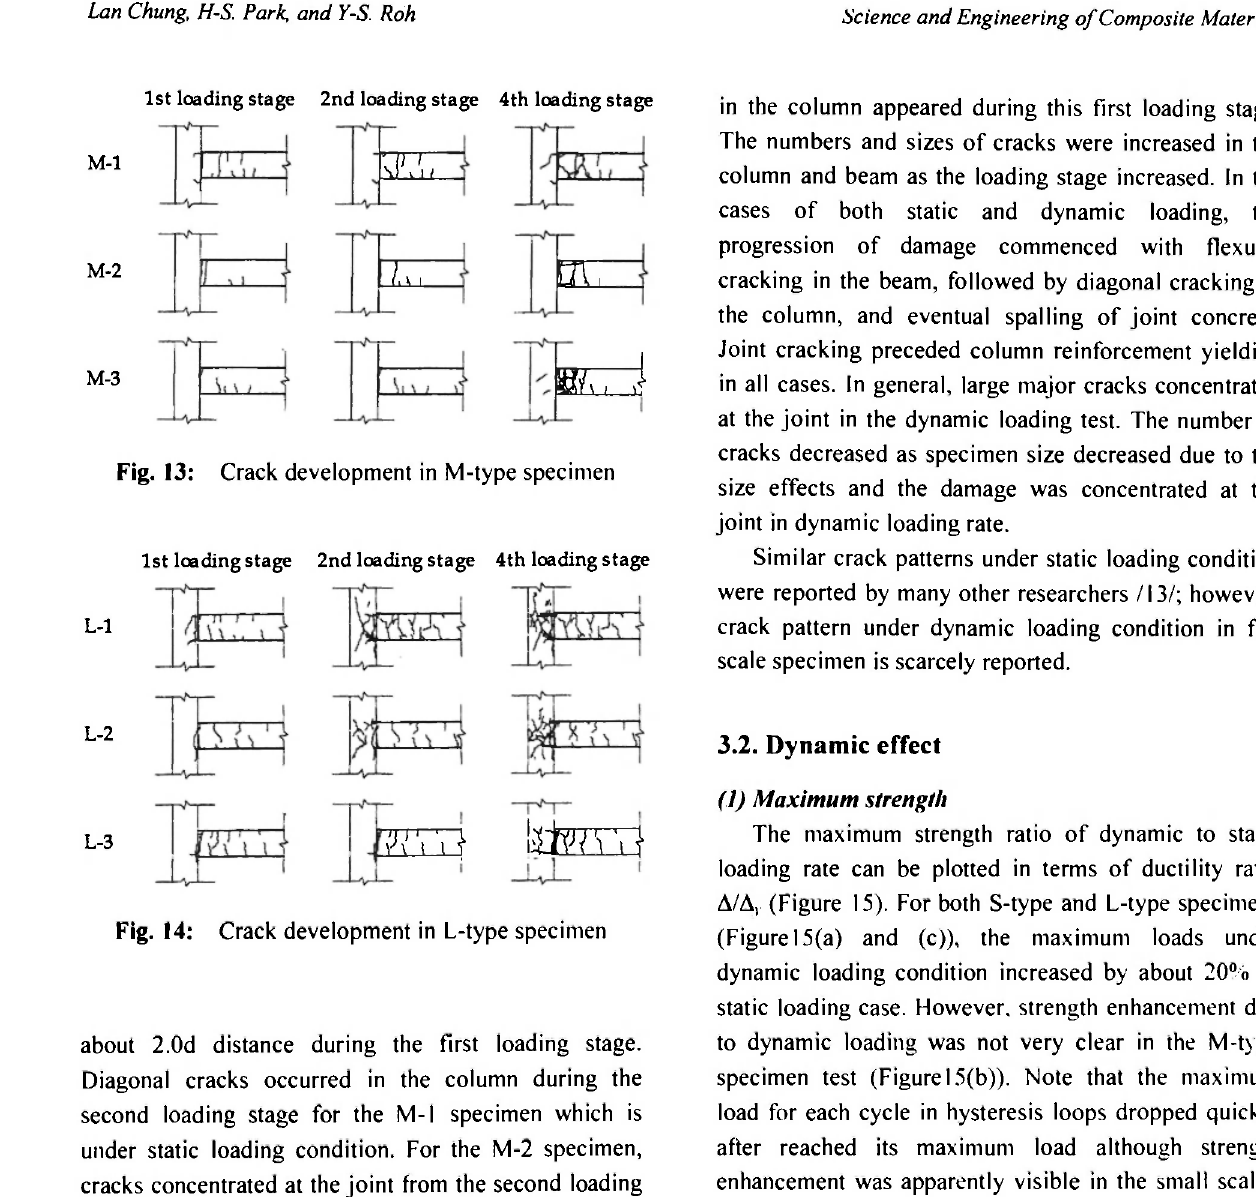
Fig. 13: Crack development in M-type specimen